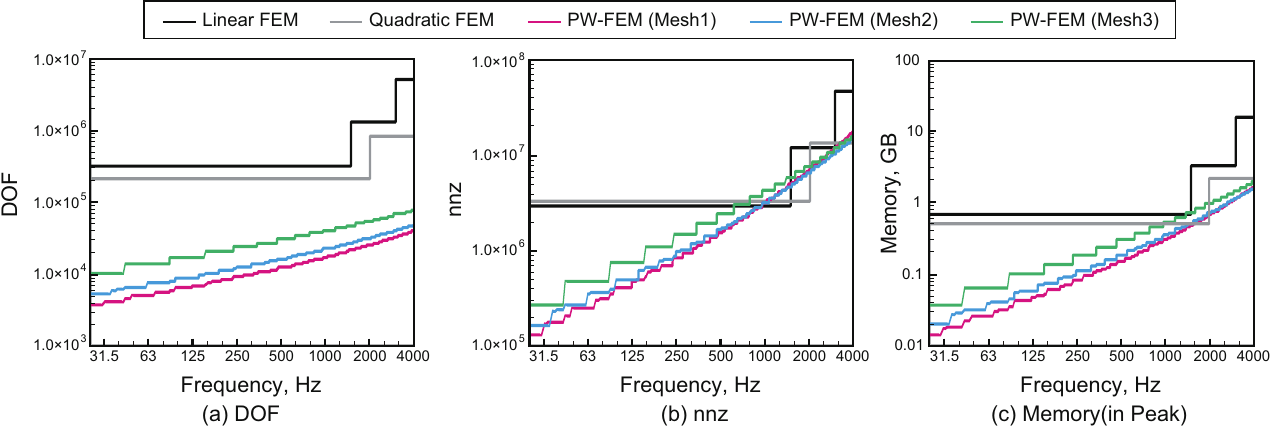
Figure 13. Comparisons of ( a ) the DOFs, ( b ) the number of nonzero elements, and ( c ) the peak memory consumption, of the PW-FEM with Mesh 1, Mesh 2, and Mesh 3 and the classical linear and quadratic